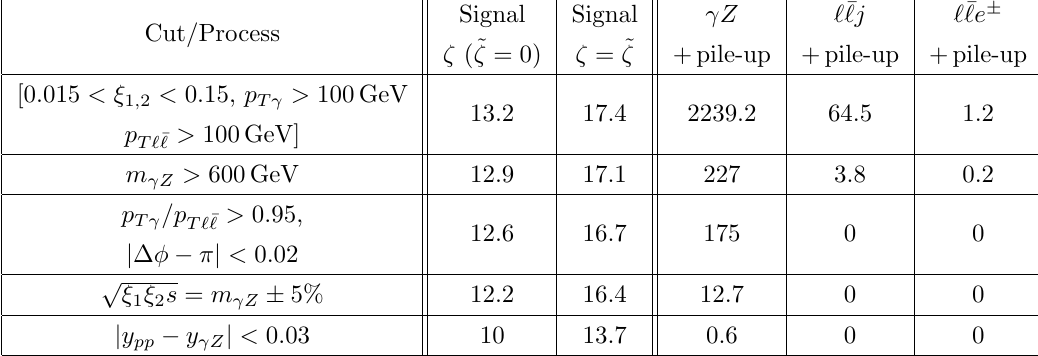
Table 2 . Same as table 1 for the ‘ (cid:22) ‘(cid:13) channel. The selection yields a signal e(cid:14)ciency of about 75% with an essentially background-free measurement in this channel.